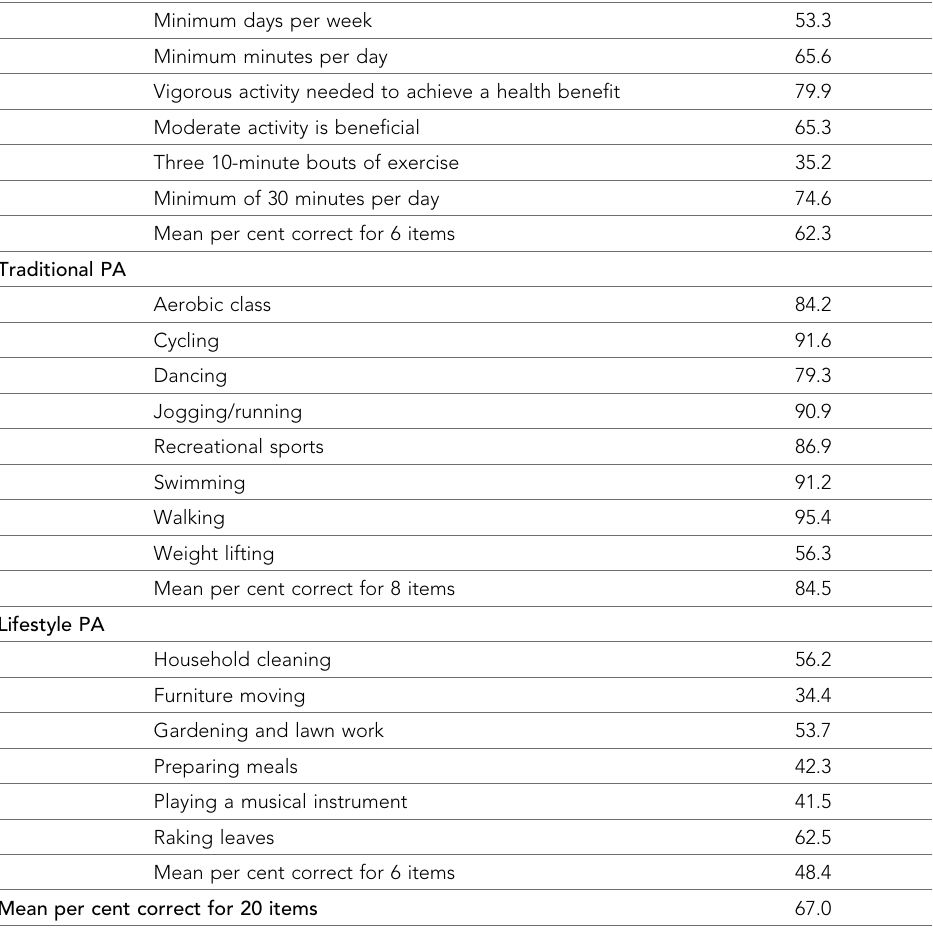
Table 2. Overall knowledge about Centers for Disease Control and Prevention/American College of Sports Medicine PA guidelines ( n =